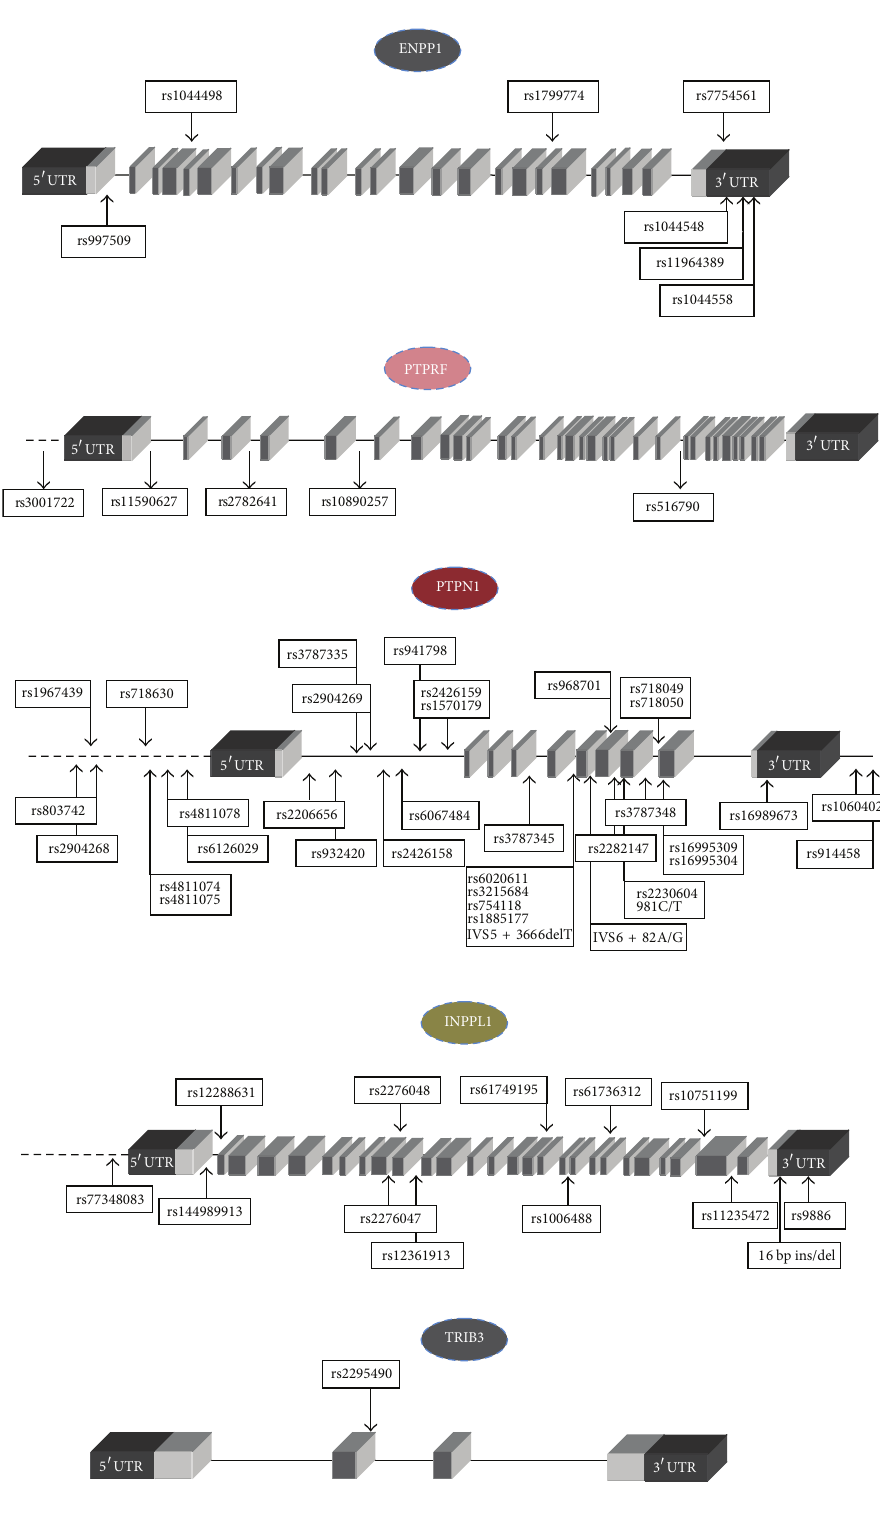
Figure 2: Genomic structure of insulin-signaling inhibitor molecules with selected single nucleotide polymorphisms (SNPs). Disease- associated SNPs are reported in boxes. Dark grey blocks = 5 󸀠 and 3 󸀠 UTR regions; light gray blocks = exons; dotted lines-promoter